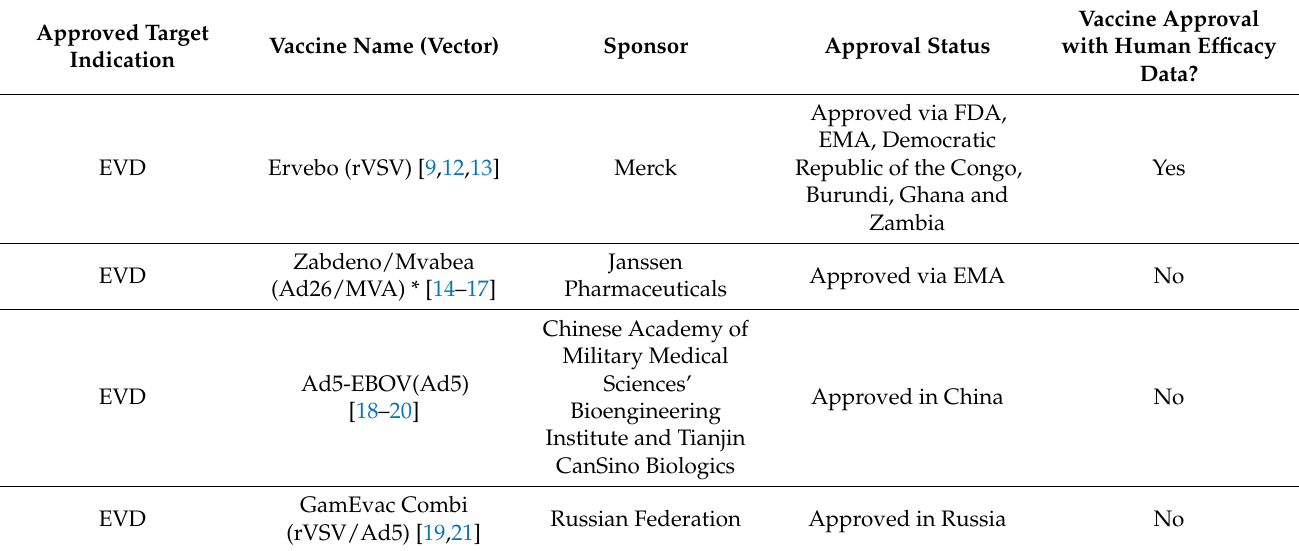
Table 1. Approved Filovirus